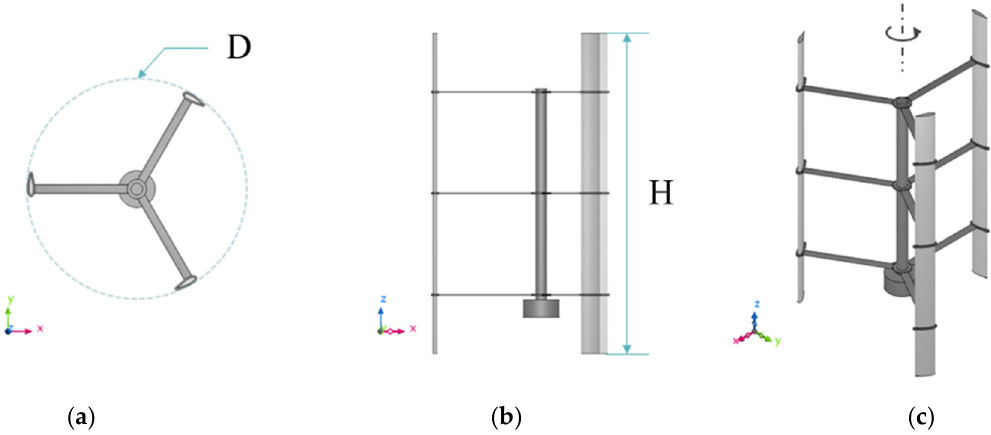
Figure 2. Detail view of the H-Darrieus rotor ( a ) rotational diameter ( b ) blade height ( c ) perspective view [17].